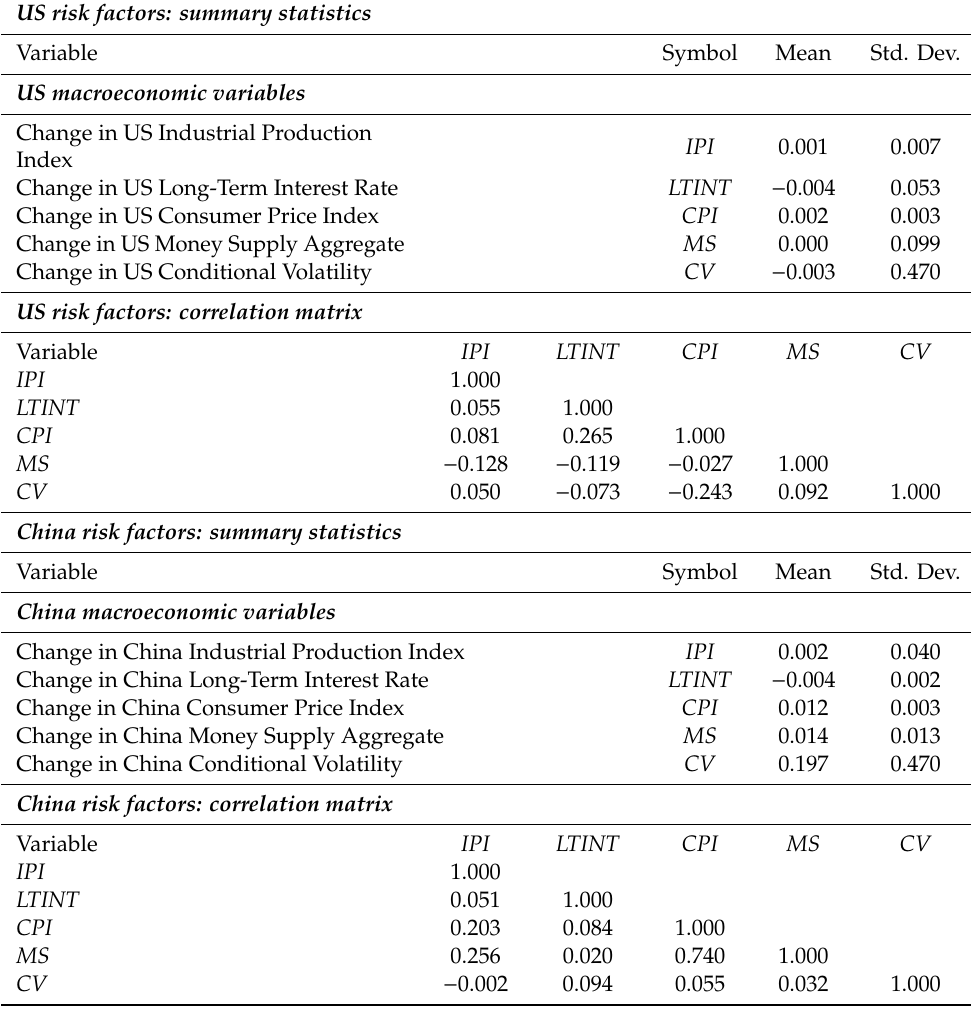
Table 3. Descriptive statistics of the US and China macroeconomic variables: 1 / 1998–4 /